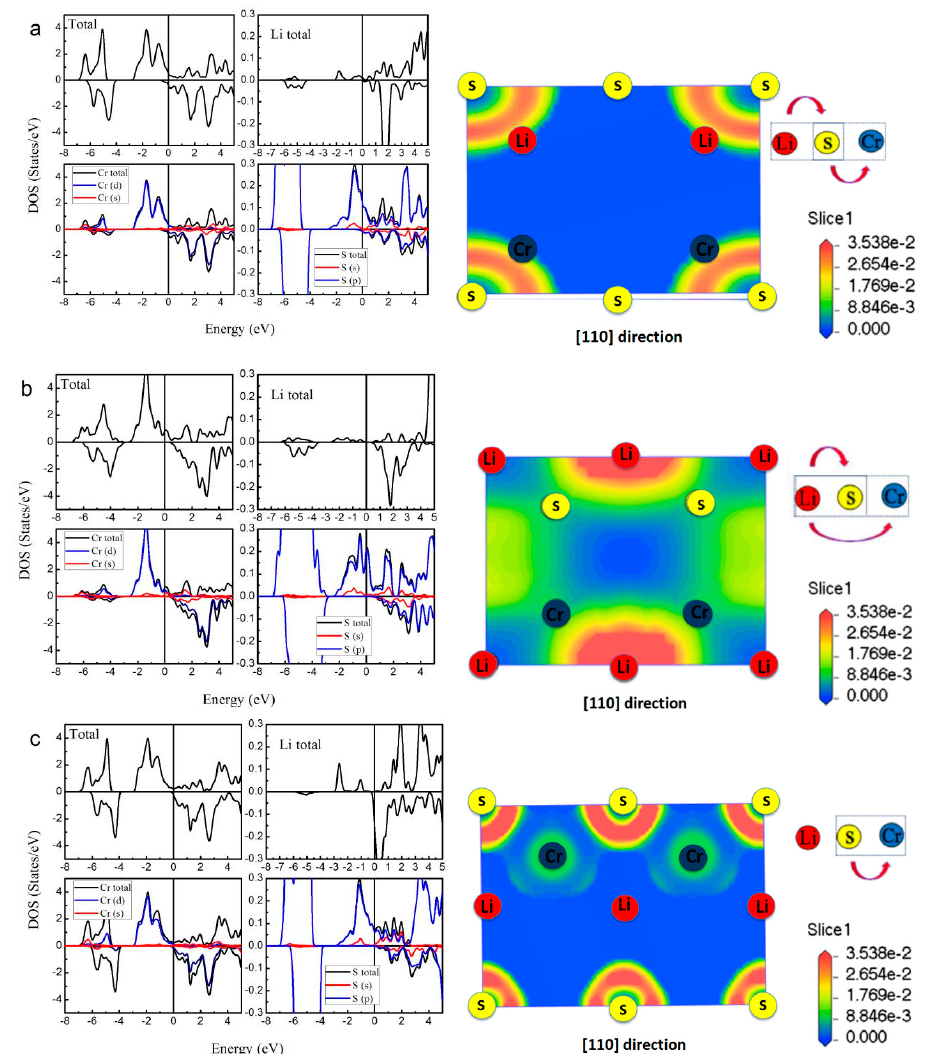
Figure 6. Calculated total and atom-projected DOS, and the electron localization function (ELF) graphs of the LiCrS alloy in the three atomic arrangements: type I ( a ); type II ( b ); and type III ( c ). (The Fermi level E F was set as X = 0).